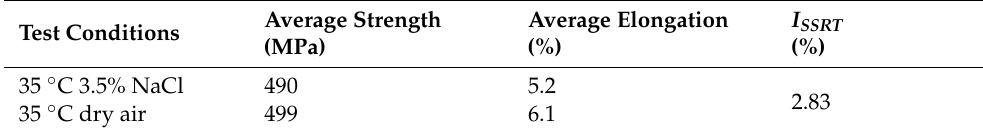
Table 1. Test results of traditional stress corrosion.